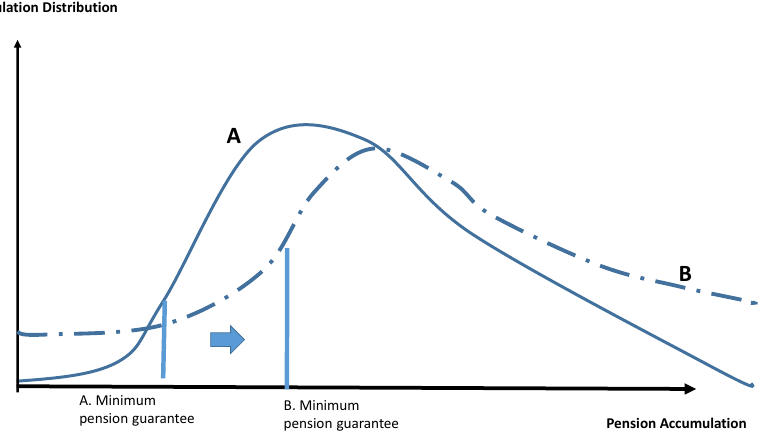
Figure 2. Income Distribution and the Minimum Pension Guarantee Level.